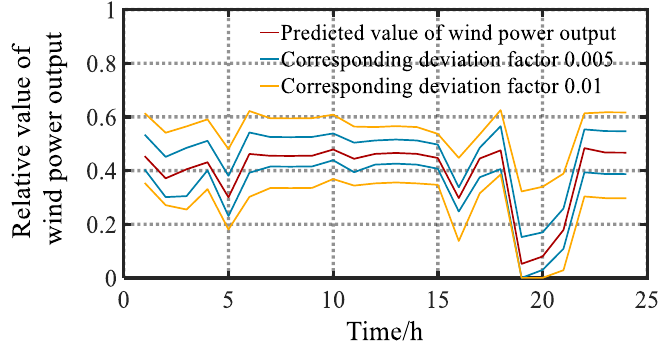
Figure 7. Wind power output range.